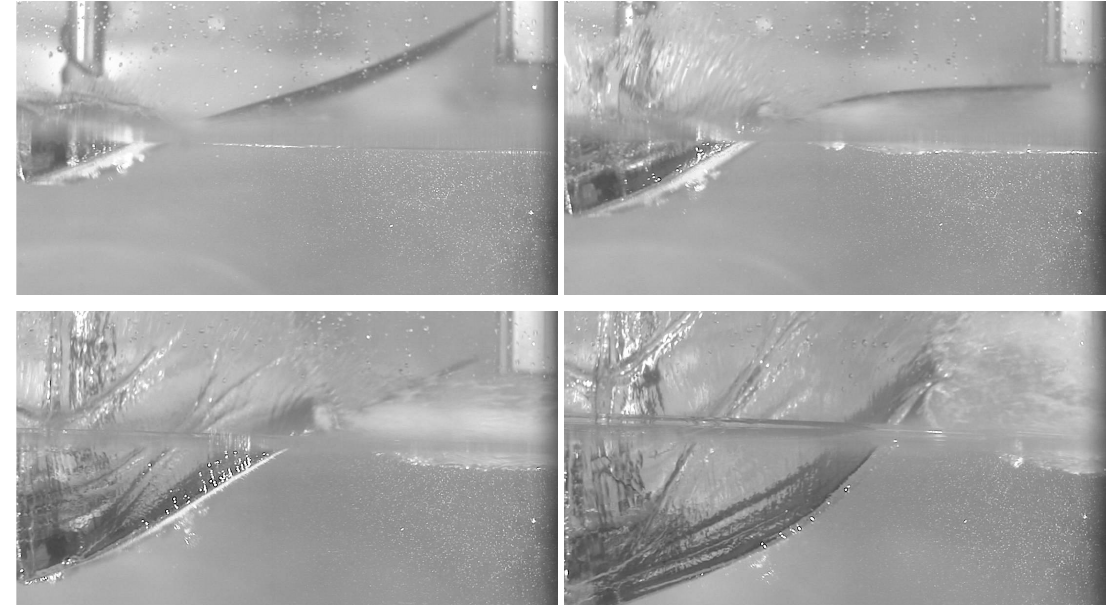
Figure 8. Deformation over time of wedge (V) 2 mm thick ( β = 20 ◦ ) entering the water at 6.7 m/s. Time advances left to right, top to